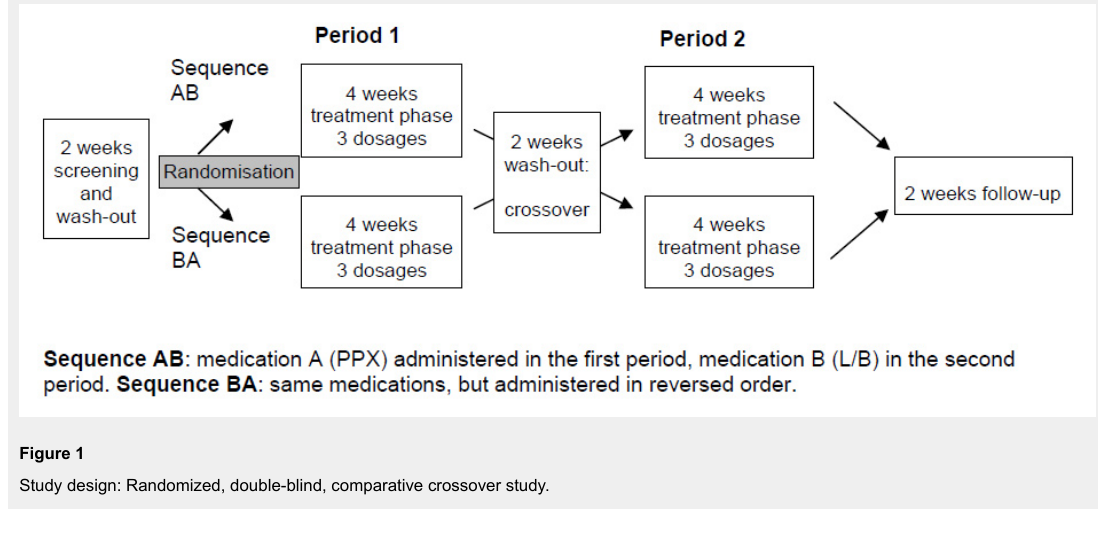
Study design: Randomized, double-blind, comparative crossover study.